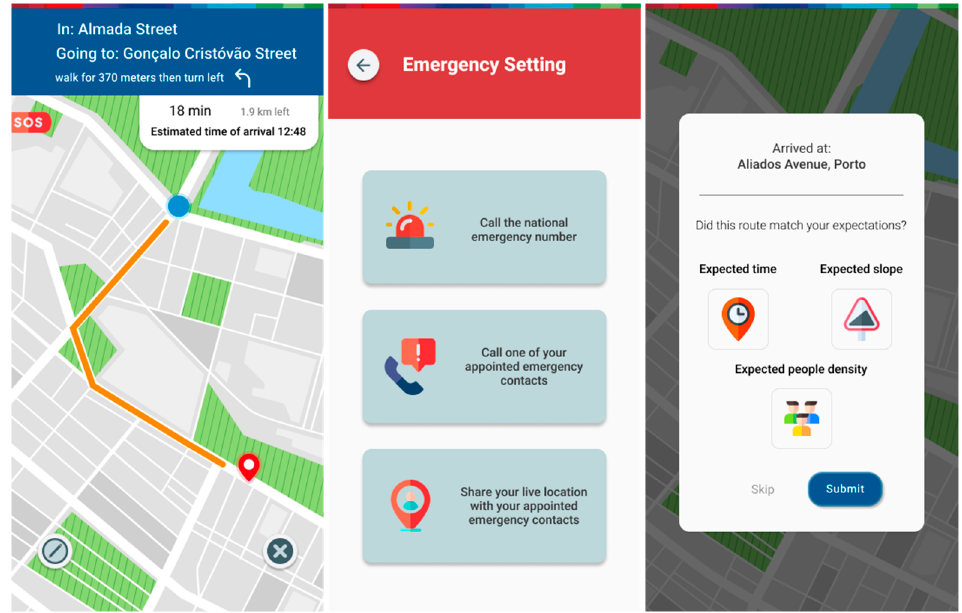
Figure 12. Route ongoing navigation screen, SOS screen, route finished feedback screen.